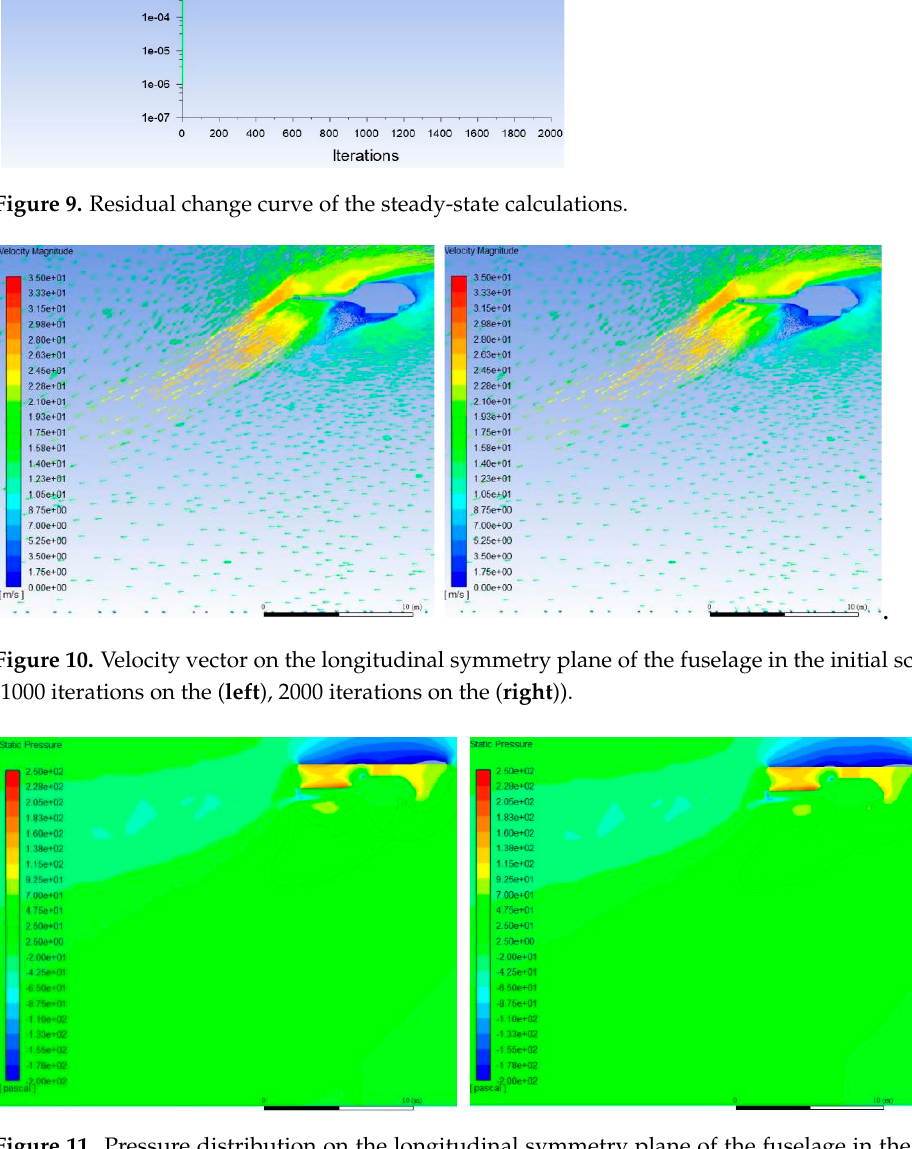
Figure 11. Pressure distribution on the longitudinal symmetry plane of the fuselage in the initial scenario (1000 iterations on the left , 2000 iterations on the right ).